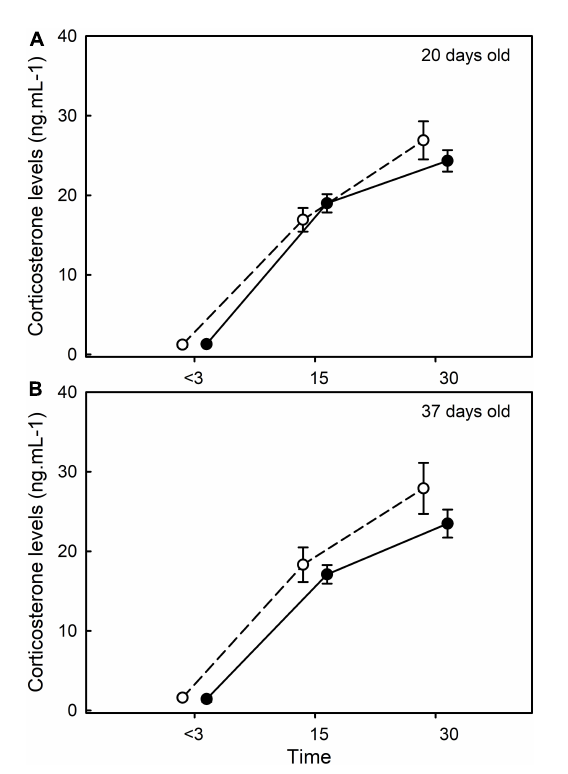
FIGURE4 Influence of previous exposure to stress (i.e., capture/restraint protocol) on the corticosterone stress response of 20-days old (A) and 37-days old (B) chicks. Mean ± SE are represented and no significant differences were found. Black and white dots represent the petrels that have been previously captured or not,